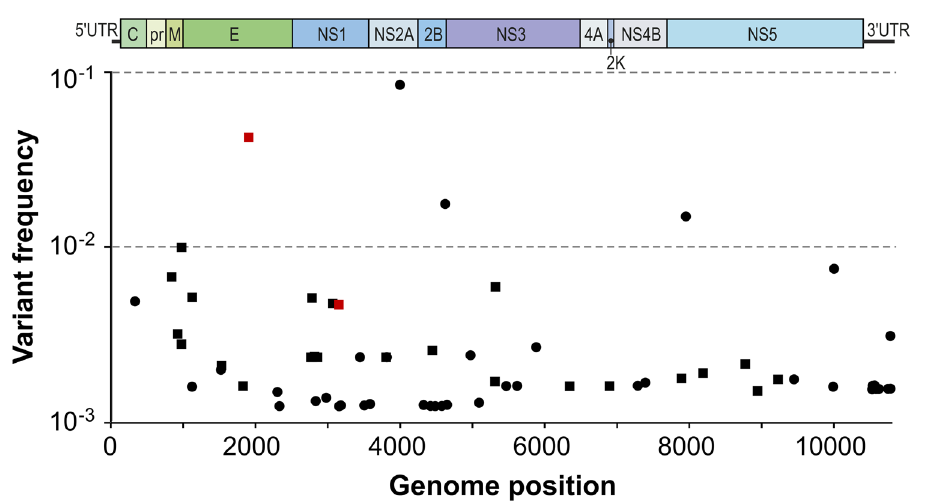
Figure 3. Quasispecies population of ZIKV SL1602. Synonymous substitutions are indicated by dots and nonsynonymous substitutions by squares. Red squares indicate SNVs that became dominant (fixed) when the virus was passaged 9 more times on Vero